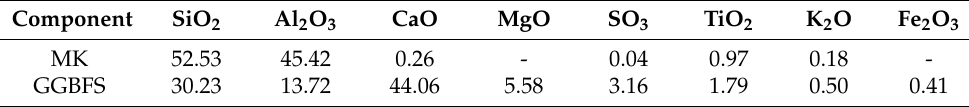
Table 1. Main chemical components of MK and GGBFS (wt.%).